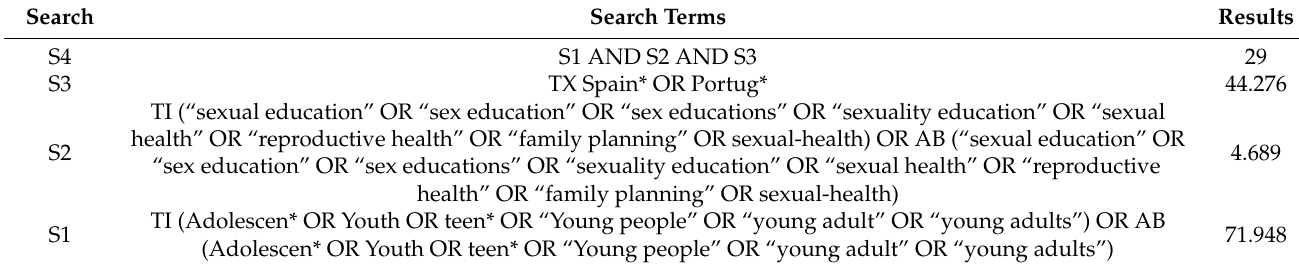
Table A6. Search at Psychology and Behavioral Sciences Collection via EBSCO in 6 April 2021.